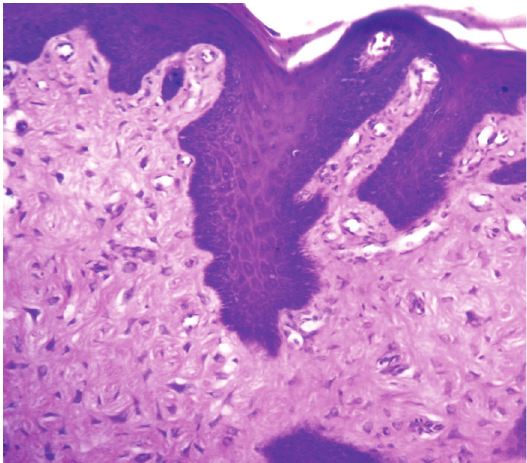
Figure 2: Photomicrograph showing dense collagen fibers with numerous giant cells, especially near epithelium. (Hematoxylin and Eosin, original magnification 10x).